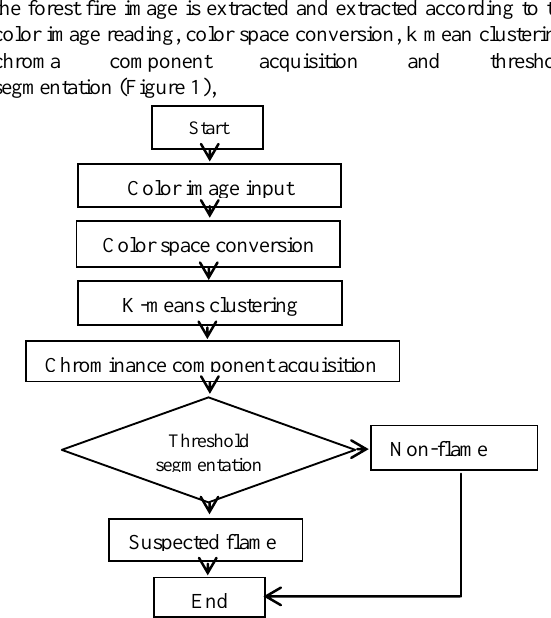
Figure 1 Forest Flame Segmentation Extraction Flow